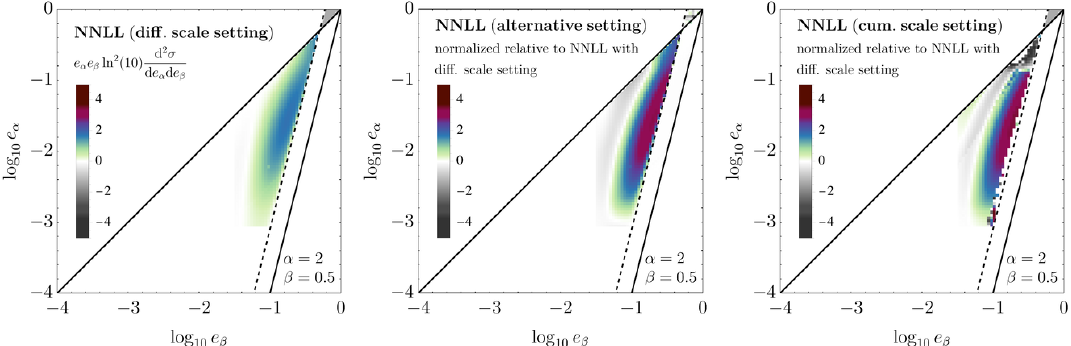
Figure 4 . NNLL cross section with di(cid:11)erential scale setting (left), with di(cid:11)erential scale setting plus extra NNLL terms in eq. (2.62) evaluated using canonical scales (center) and with cumulative scale setting